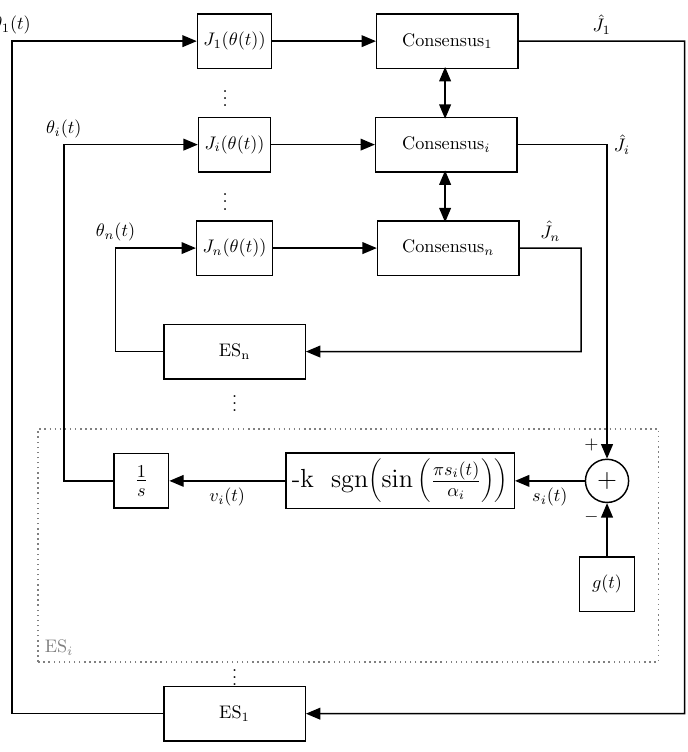
Figure 5. Implementation of the proposed distributed ES